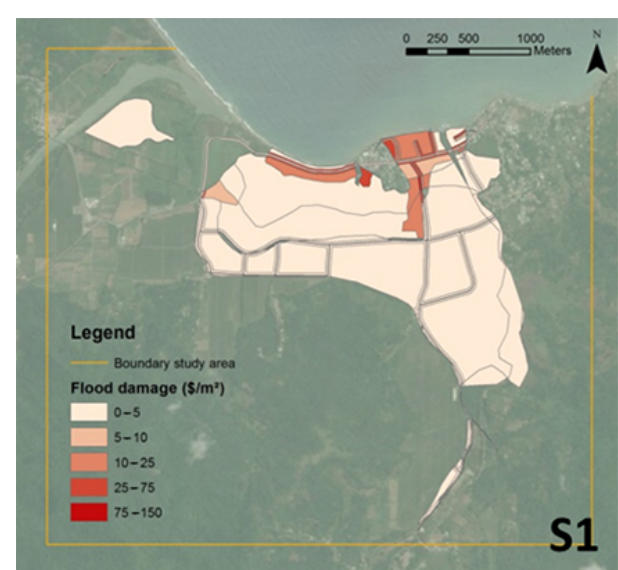
Figure 4. Scenario 1 (S1): benchmark damage map of Annotto Bay, using all available input data.